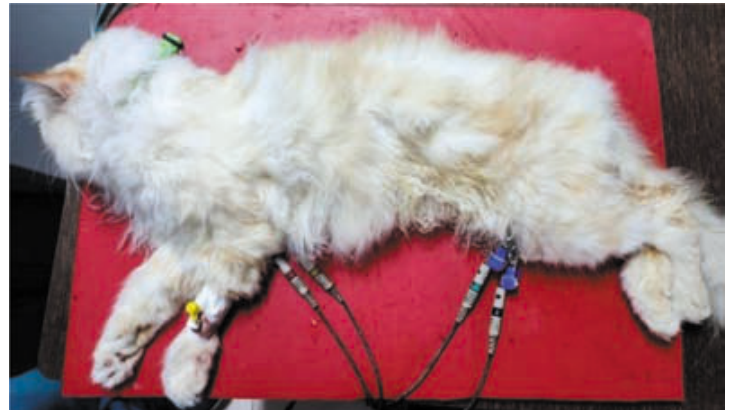
Fig. 1. Positioning of cat for electrocardiography